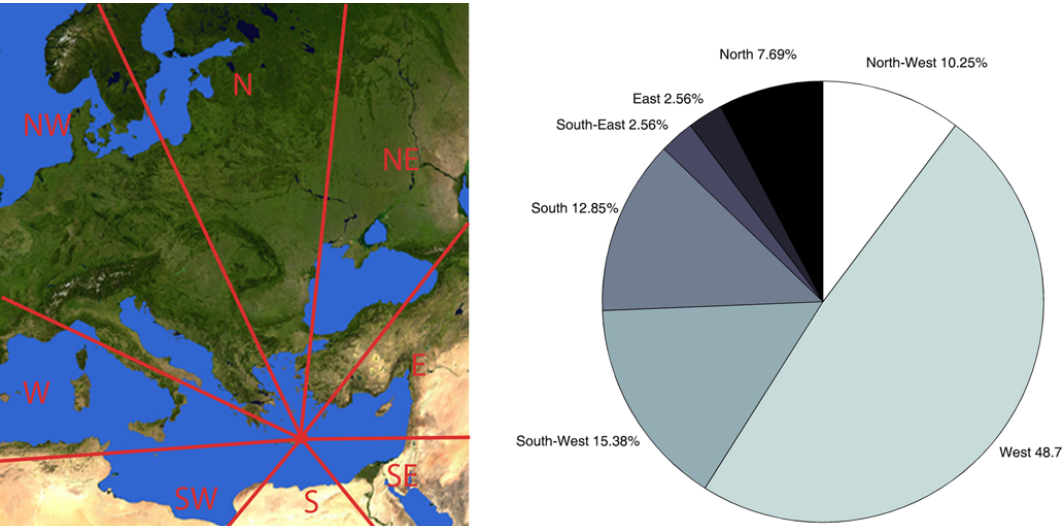
Fig. 10. Distribution of air masses origin at 1000m (5 days back trajectory) arriving at Finokalia during night-time enhanced ion concentra- tions